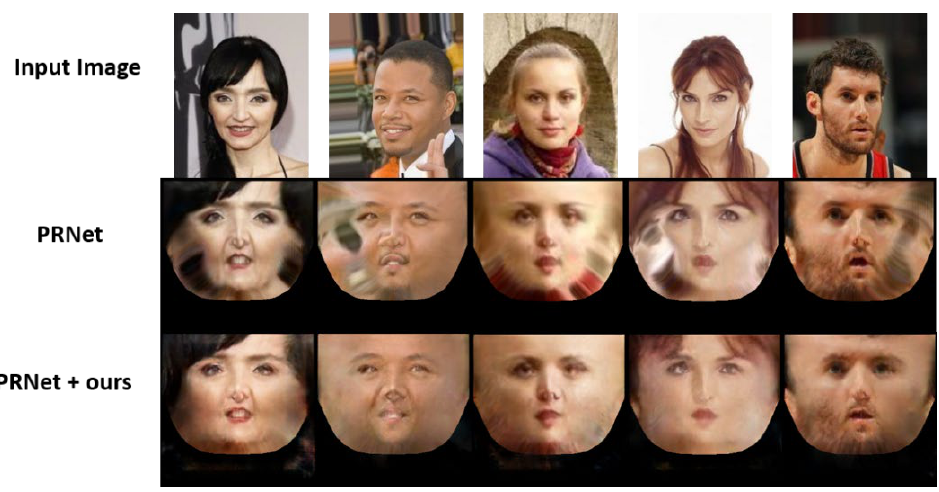
Figure 14. Texture generation result in Celeb-A dataset.